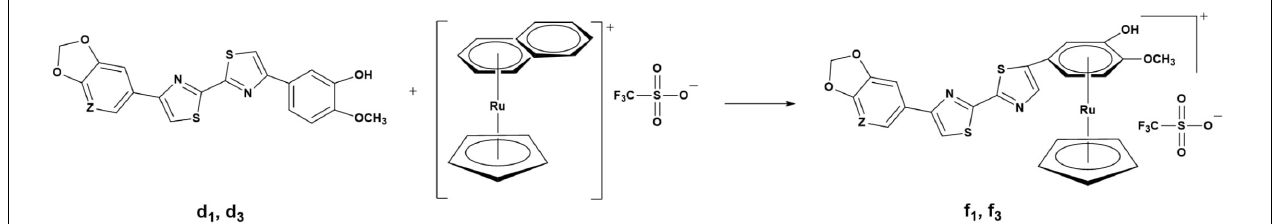
FIGURE 3 | General synthesis of the DABTAâ ˘A ¸Sruthenium complexes in a mixture of dichloroethane and acetonitrile at 60 ◦ C for 24h with ( η 5-cyclopentadienyl) ( η 6-naphthalene)ruthenium(+)trifluoromethanesulfonate. Where: Z = N, CH.